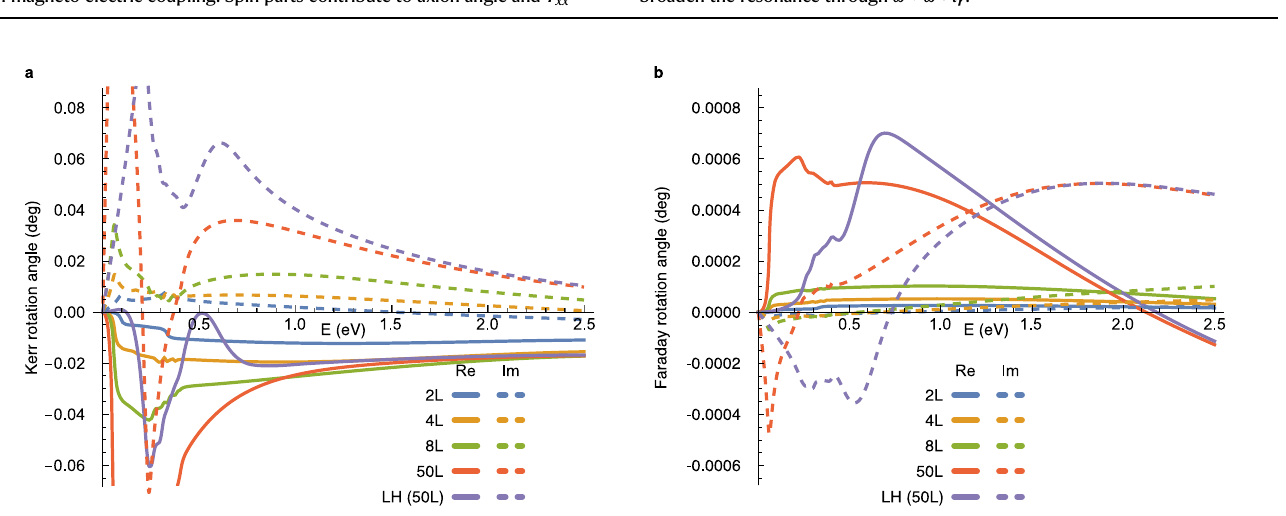
through θ ð z Þ , s = ð 2 G s xx + G s zz Þ = 3 and T s xx = ð G s xx (cid:1) G s zz Þ = 3. c Spectra for two layers. These are three orders of magnitudes smaller than the orbital axion magneto- electric coupling. d Layer-number dependence at photon energy ℏ ω =2 eV. Solid and dashed lines are curves fi tted with a / N l + b form, where a and b are fi tting parameters. All optical response functions are calculated with γ =10 meV to broaden the resonance through ω → ω + i γ